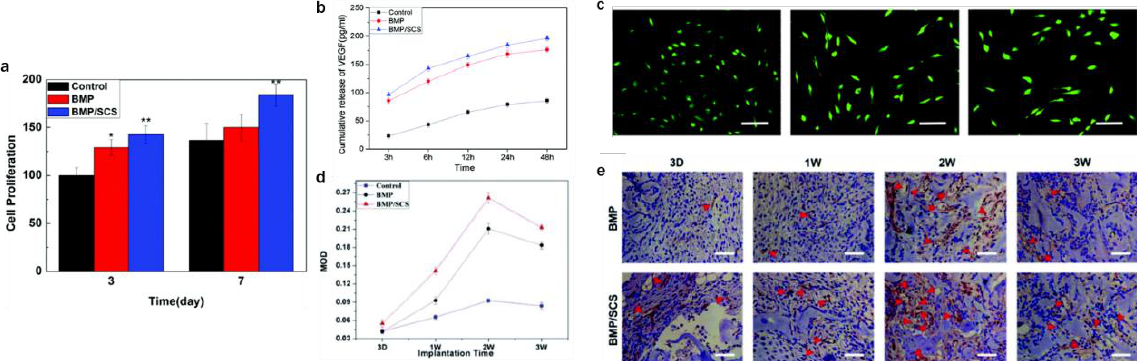
Figure 9. ( a ) Cell viability of BMSCs treated with BMP-2 and BMP-2/SCS determined by the MTT assay, (*) denotes significant difference ( p < 0.05) as compared to the control group, (**) denotes p < 0.05 compared to both control and BMP-2 group; ( b )Secretion kinetics of VEGF from BMSCs after culturing with BMP-2 and BMP-2/SCS. ( c ) Intracellular NO secretion of BMSCs in the culture medium (control group), BMP-2, and the BMP-2/SCS group, ( d ) Immunohistochemican anti-CD31 staining of the ectopic bone section, and ( e ) The statistical analysis of blood vessels after the microvessel counting was conducted at 200 × . Probability ( p ) value of b0.05(*) is considered as significant and ( p ) value of b0.01(**) is considered to be highly significant. Data were redrawn from [230] .